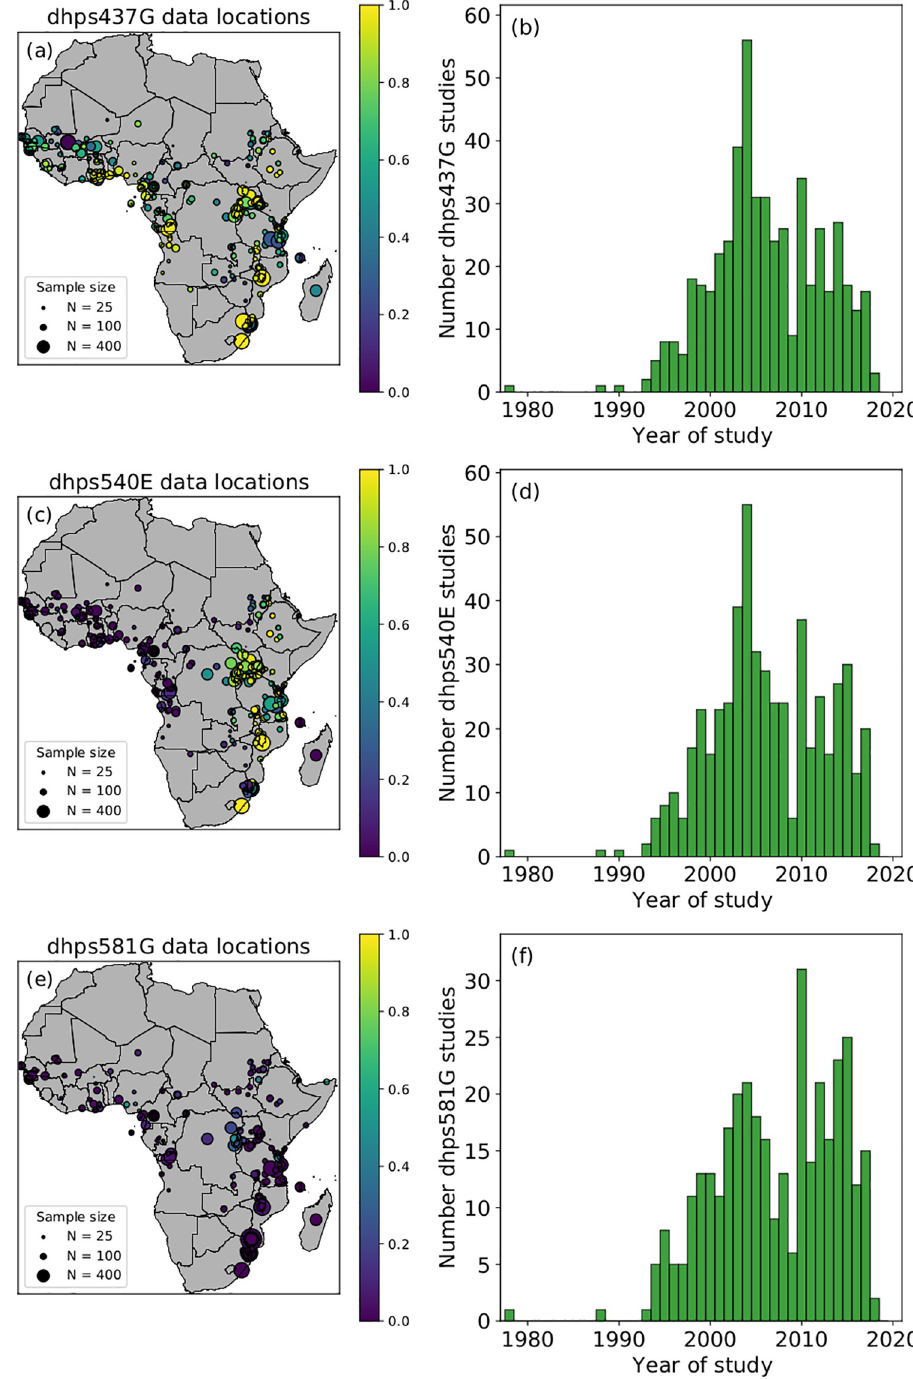
Fig 1. Spatial locations and pfdhps mutation prevalence from collected data. Summary of the spatial locations of the collected data and the prevalence for pfdhps 437G (a), pfdhps 540E (c) and pfdhps 581G (e) across the African continent and the number of study sites per year during the time period 1980–2020 for pfdhps 437G (b), pfdhps 540E (d) and pfdhps 581G (f). In (a), (c) and (e), the size of the dots is proportional to the study sample size and the colour is representative of the observed marker prevalence. National shapefiles were obtained from the Malaria Atlas Project (MAP; https://malariaatlas.org/) under their open access policy (https://malariaatlas.org/open-access-policy/) and no changes were made.